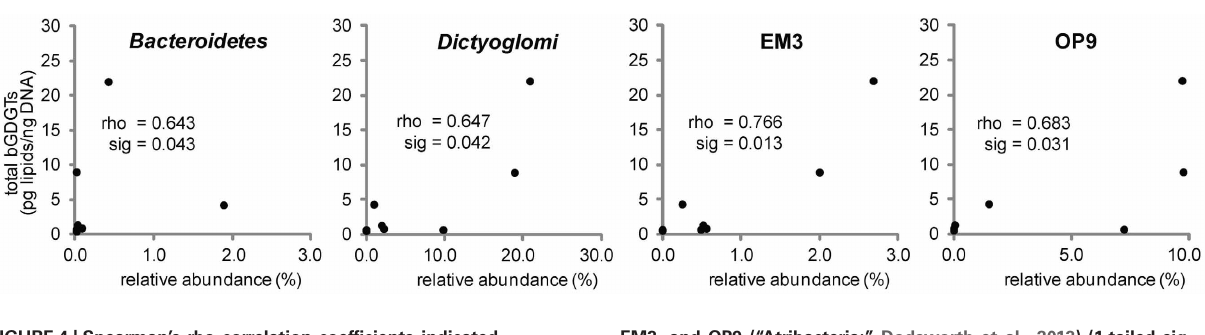
EM3, and OP9 (“Atribacteria;” Dodsworth et al., 2013) (1-tailed sig. shown). Total bGDGT abundance, including core- and polar lipids, were normalized to ng